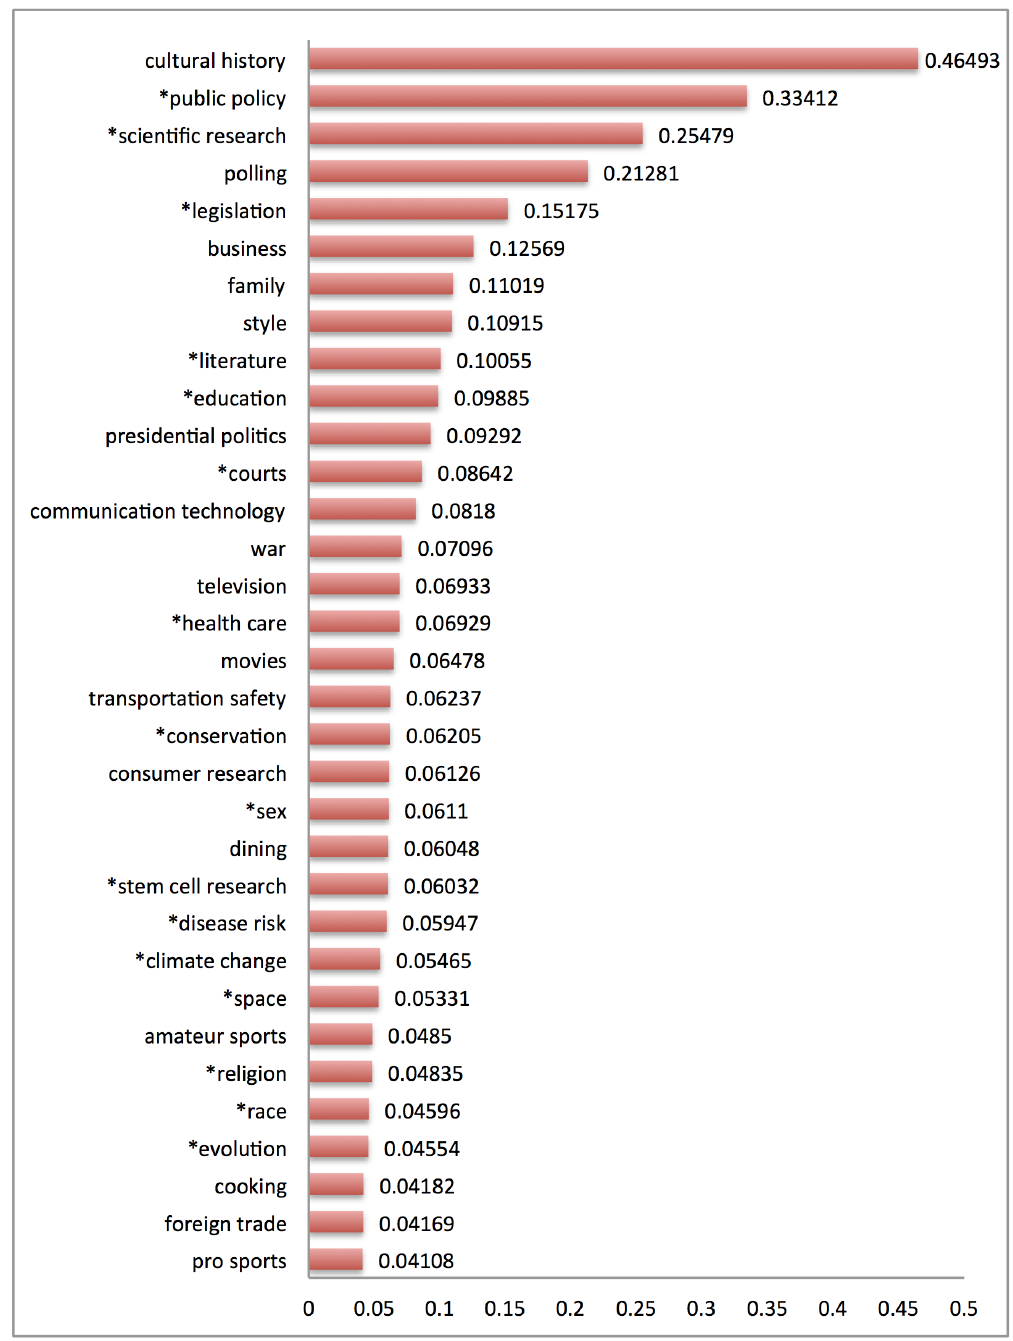
Figure 4. Labeled substantive topics ranked by topic Dirichlet parameter. The greater the topic Dirichlet parameter, the greater the proportion of the corpus assigned to the topic. Asterisks indicate subjects previously identified in qualitative case studies of demarcation.